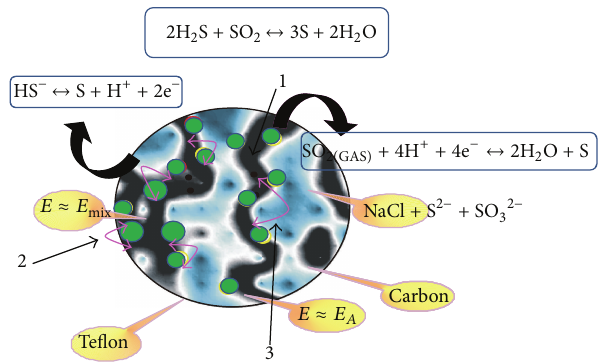
Figure 1: The physical model of a pore of a microgalvanic element with teflonized charcoal/carbon black and a catalytic mass for the reductionreactionofSO 2 withtheoxidationofH 2 Sintheelectrolyte containing H 2 SO 3 + NaCl + NaOH + Na 2 S ⋅ 9H 2